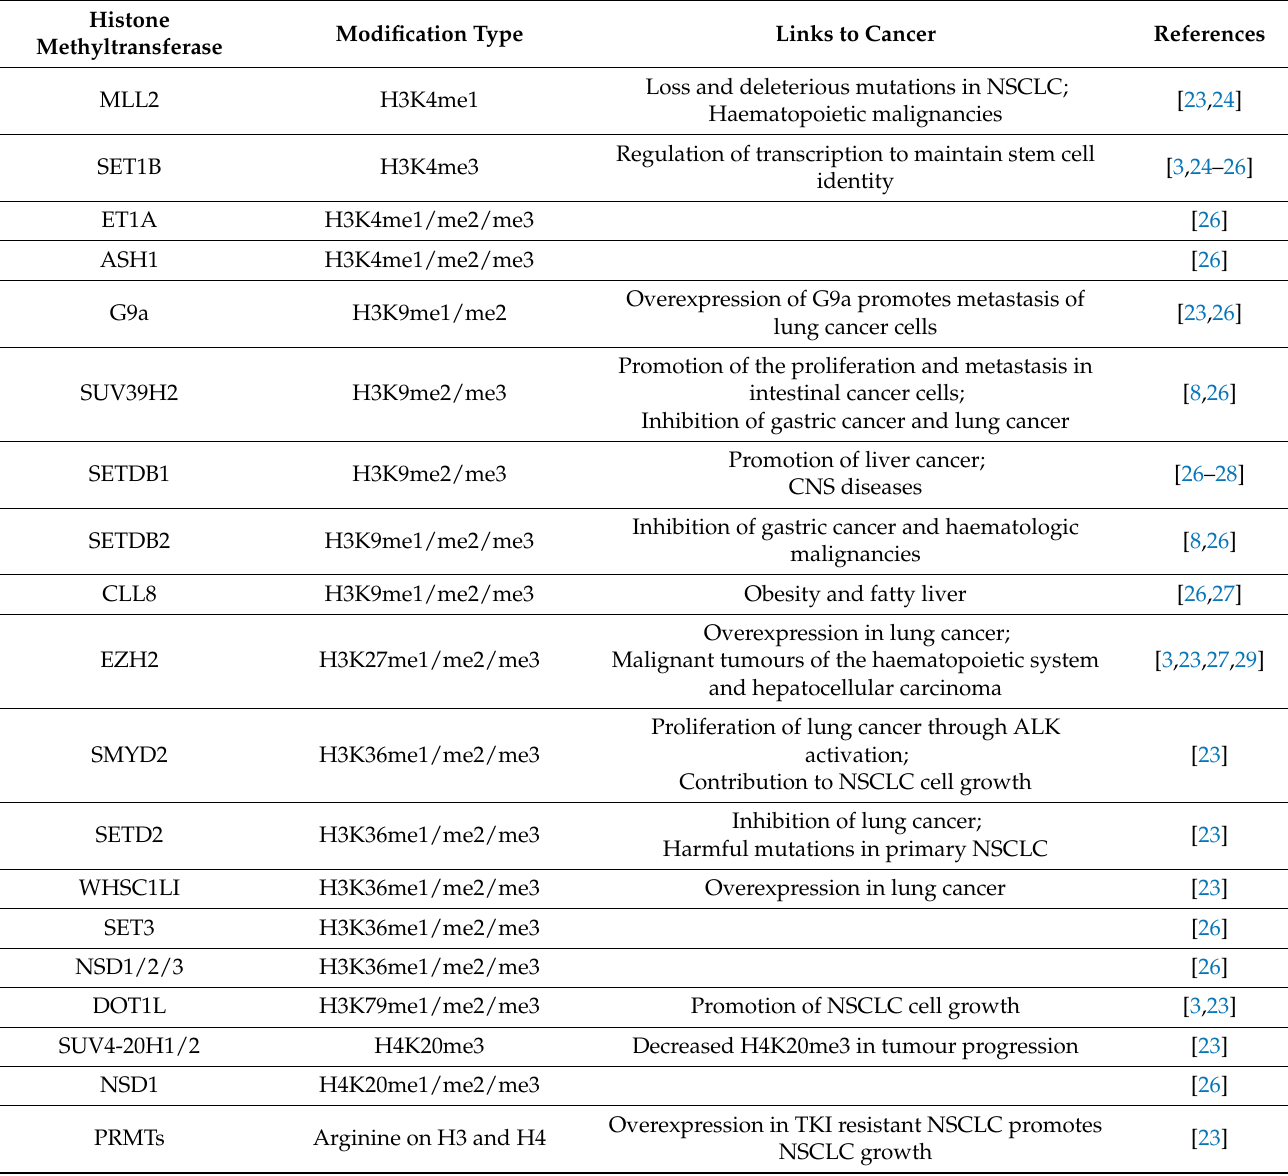
Table 1. Common histone methyltransferases and their related